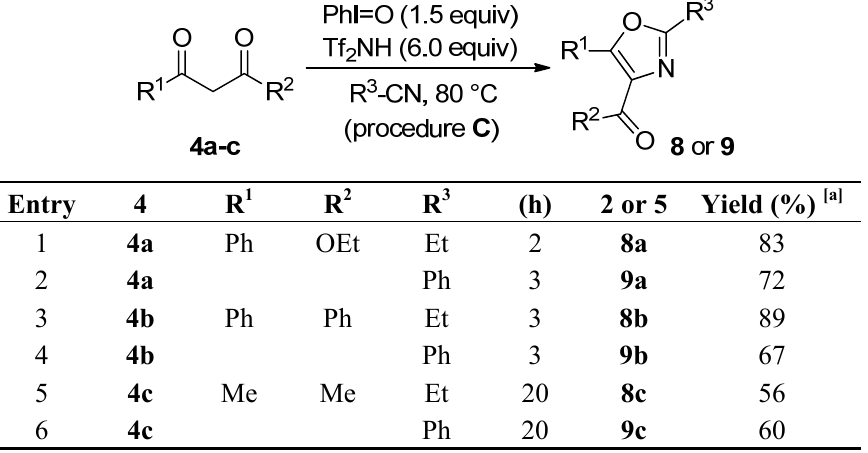
Table 4. The reactions of 4a – c in EtCN or PhCN by the means of procedure C